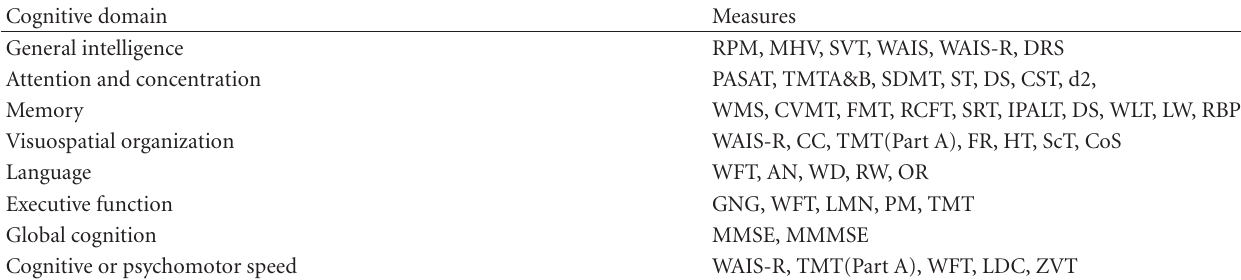
Table 1: Cognitive domains and measures (AN: animal naming; CC: cube copying; CoS: Corsi’s span; CST: concept shifting test; CVMT: continuous visual memory test; d2: d2 test; DRS: dementia rating scale; DS: digit spans forward and backward of WAIS-R; FMT: Milner facial memory test; FR: figure rotation from the Schaie-Thurstone adult mental abilities test; GNG: Go-NoGo; HT: Hooper test; IPALT: Inglis paired associates learning test; LDC: letter digit coding test; LMN: Luria m’s and n’s; LW: list of words; MHV: Mill Hill Vocabulary Scale; MMSE: Mini-Mental State Examination; MMMSE: Modified Mini-Mental State Examination; OR: oral reading; PASAT: paced auditory serial addition task; PM: Porteus maze; RBP: Rivermead behavioral profile; RCFT: Rey-Osterrieth complex figure test; RPM: raven